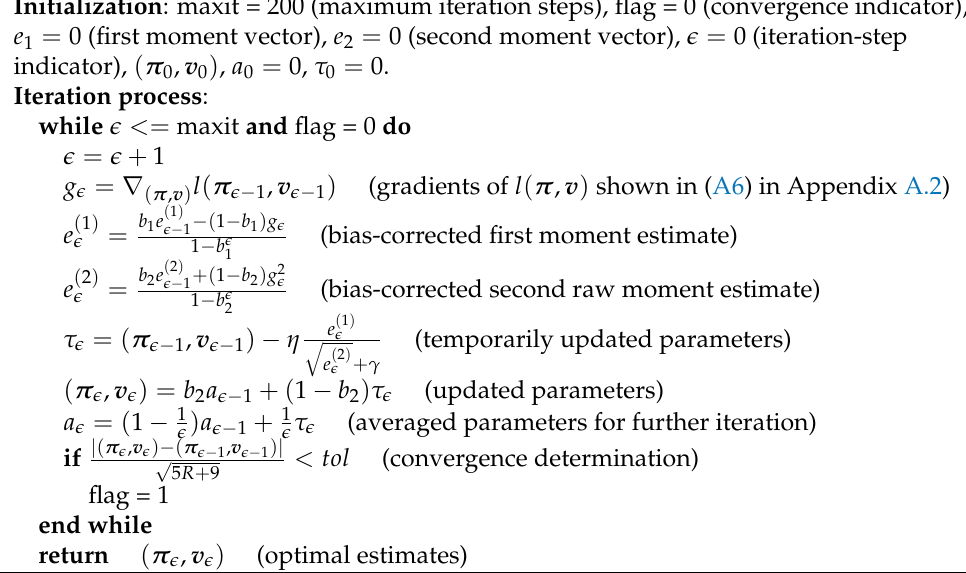
10 − 4 . All operations are ×